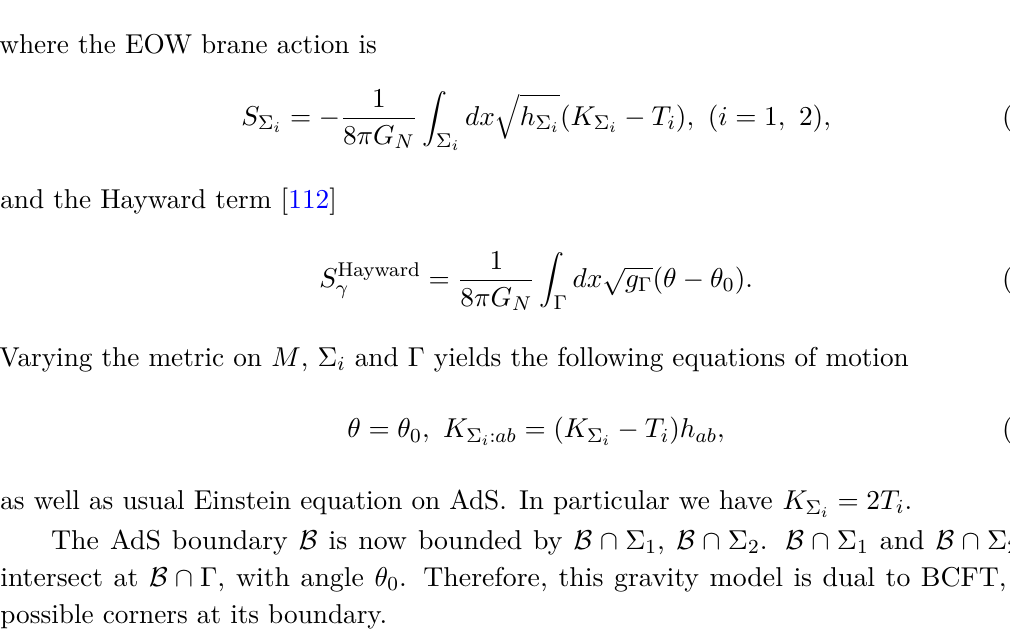
Figure 5 . Three phases of pseudo RT surface γ for a boundary subregion. ( a ) γ does not intersect with any of Σ 1 , Σ 2 and Γ . ( b ) γ ends on EOW branes Σ 1 and Σ 2 . When the set up is time reflection symmetric, there are multiple pseudo RT surfaces which are related via time reflection. ( c ) γ ends on the corner Γ